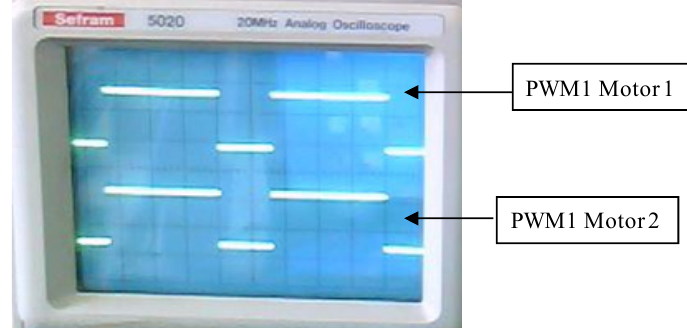
Figure 21. Generating PWM signals by PIC for controlling the rotational speed of the two motors for α = 0.75. (Scales: 2 V/Div, 20